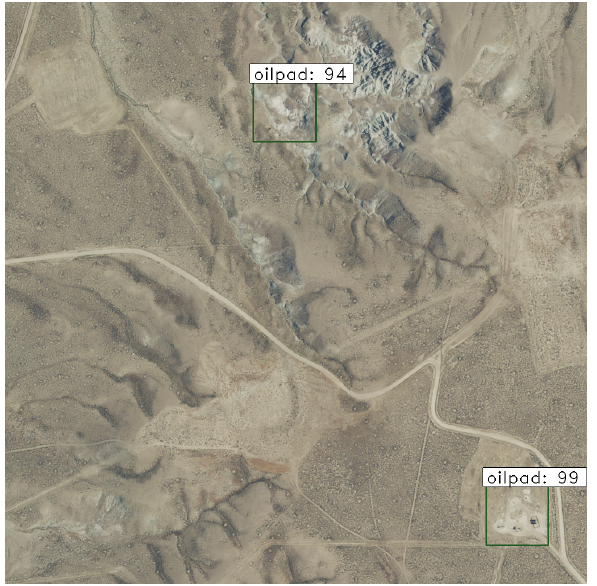
Figure 5. Model prediction on validation image from no oil pad set with abandoned oil pad and roads.